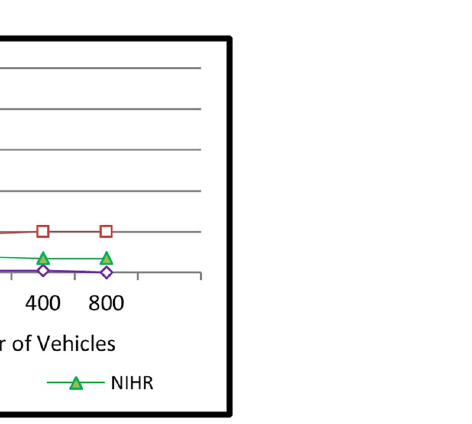
Fig 6. Information dissemination packet loss ratio using the TLILS, ZGLS, and NIHR.